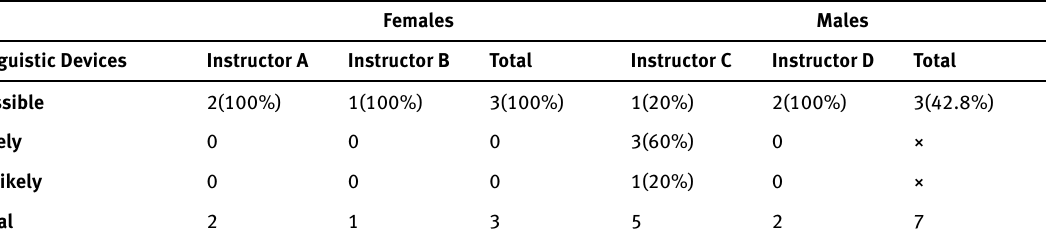
Table 7. Adjectives expressing hedging